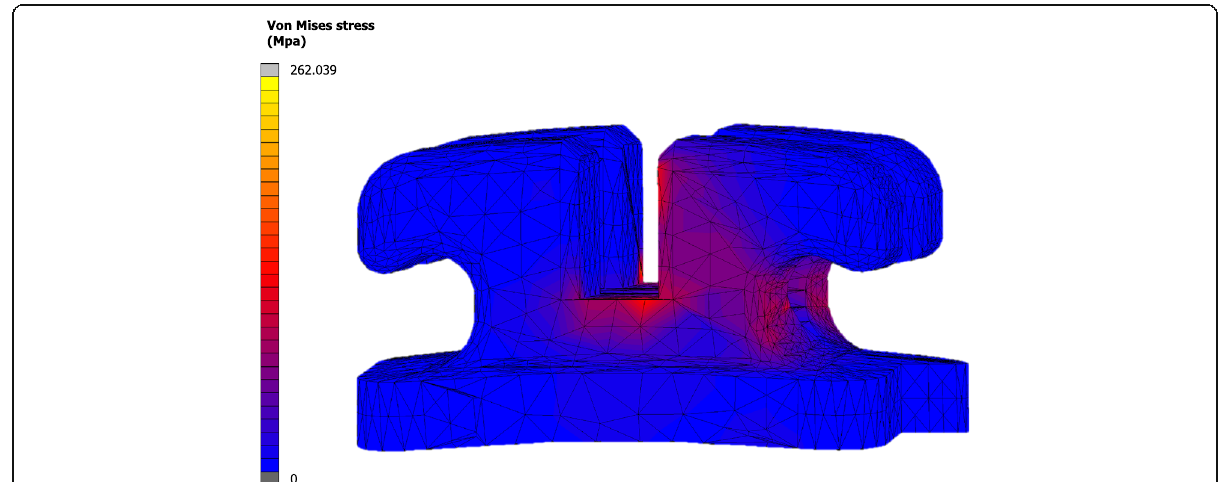
Fig. 5 Example showing the distribution of von Mises stresses in the bracket